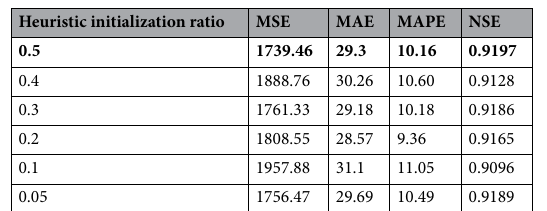
Table 4. Impact of heuristic initialization ratio. Best results are highlighted in bold text. The heuristic initialization ratio of 0.5 attains the best performance concerning all the metrics.